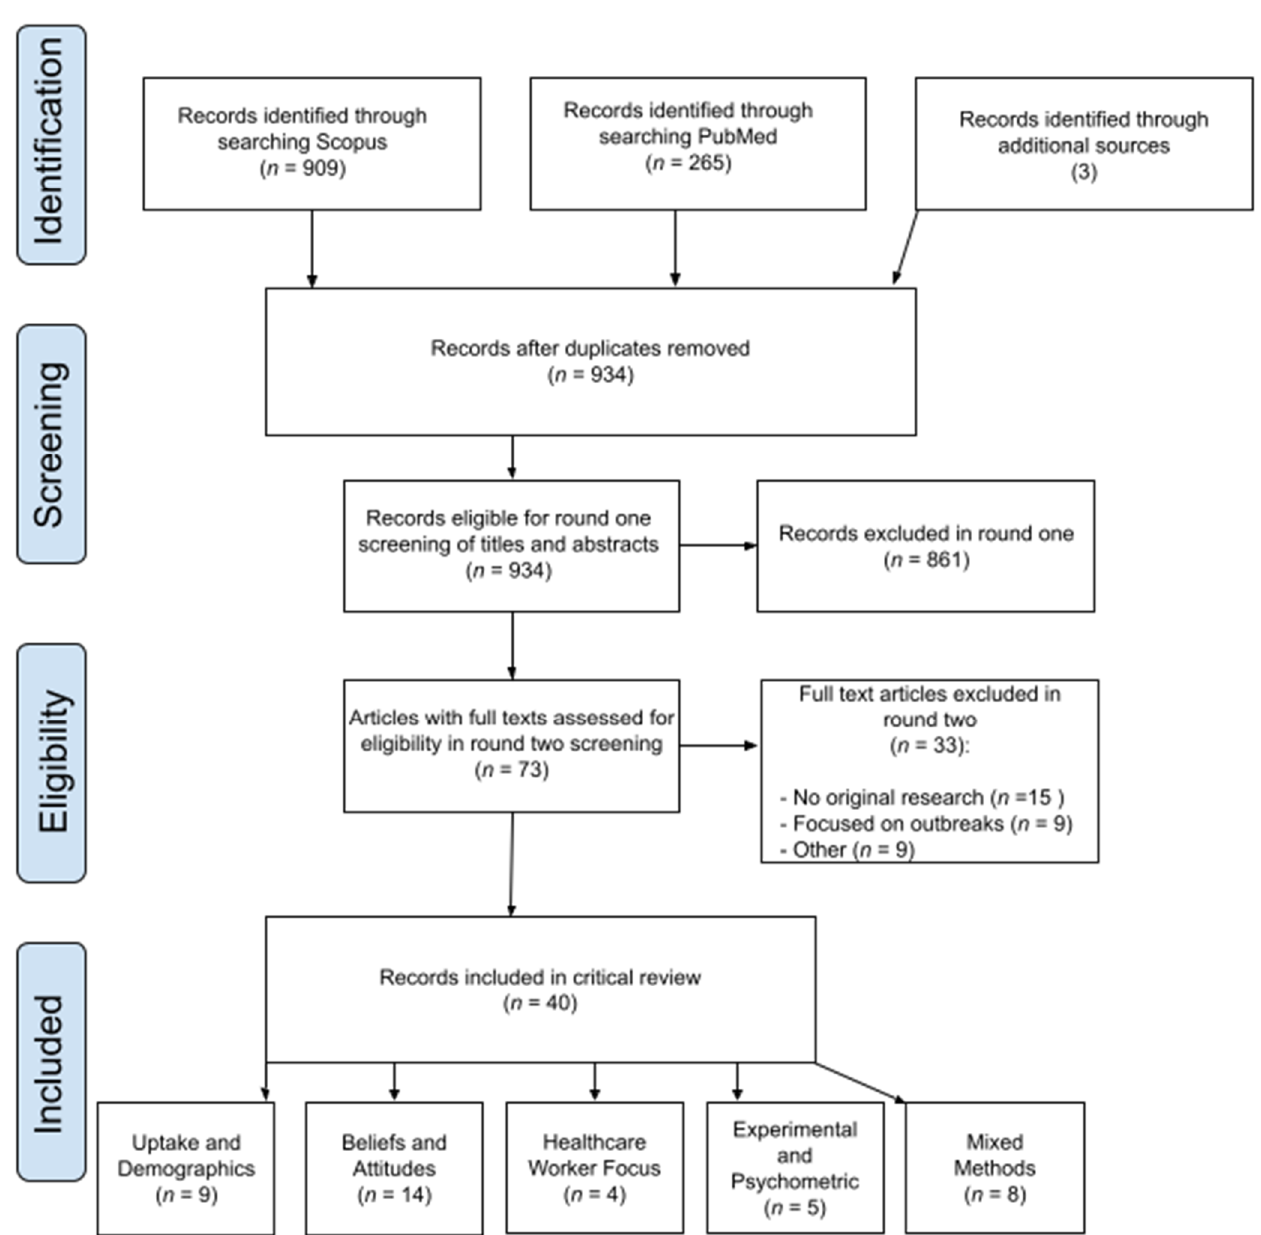
Figure 1. Adapted from [22] Moher D, Liberati A, Tetzlaff J, Altman DG, The PRISMA Group (2009). Preferred Reporting Items for Systematic Reviews and Meta-Analyses: The PRISMA Statement. PLoS Med 6(7): e1000097. doi:10.1371/journal.pmed1000097.